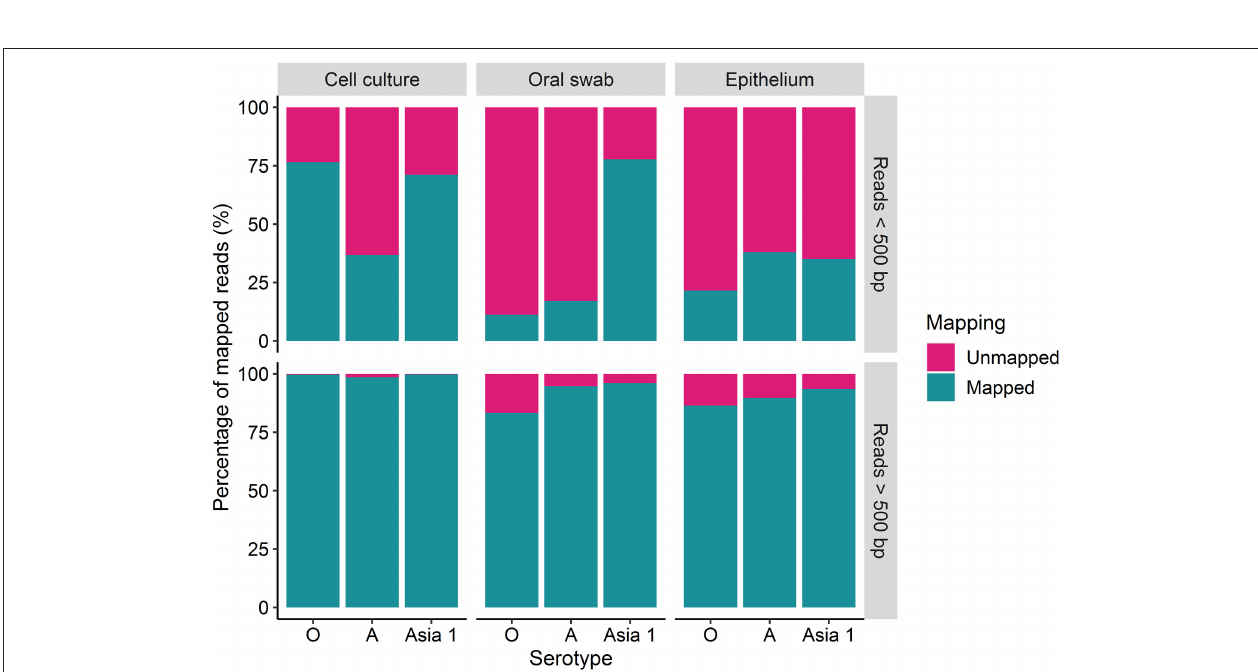
FIGURE 2 | The percentage (%) of MinION reads which were over and under 500 bp in length which mapped to the MinION derived reference sequence using reads generated after 30h of nanopore sequencing.